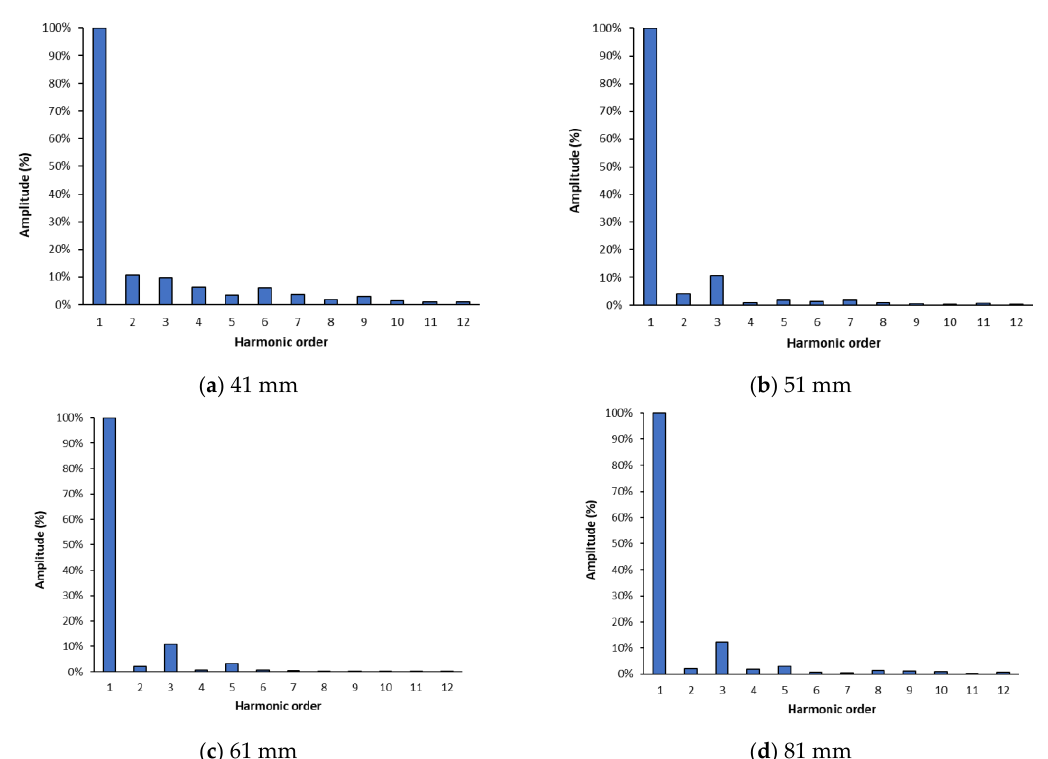
Figure 15. Harmonic analysis of the tangential E-field waveforms for an applied voltage of 8 kV rms obtained along the stress grading system at ( a ) 41 mm, ( b ) 51 mm, ( c ) 61 mm, and ( d ) 81 mm.